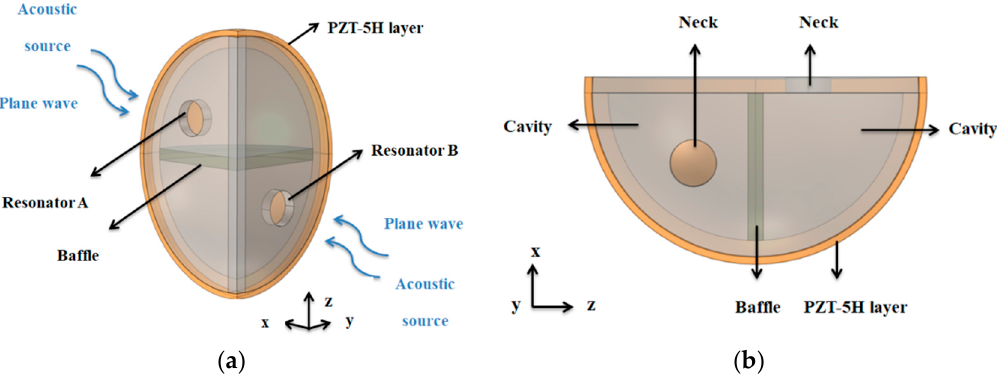
Figure 1. Structure of this quarter spherical acoustic energy harvester (AEH): ( a ) close-up view and ( b ) view in the y-direction.